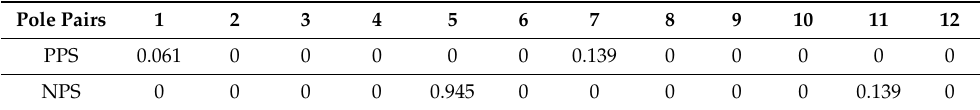
Figure 3. 8-pole and 10-pole magnetic fields. Table 3. Winding factors of DOSSR AFPM motor.